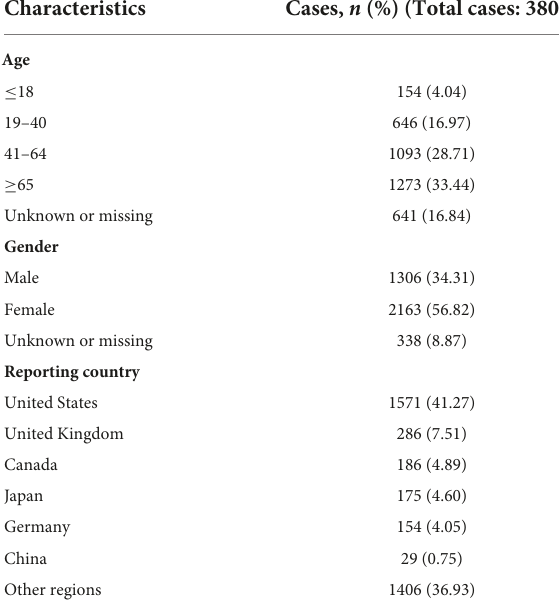
TABLE 2 Characteristics of cases with torsades de pointes.